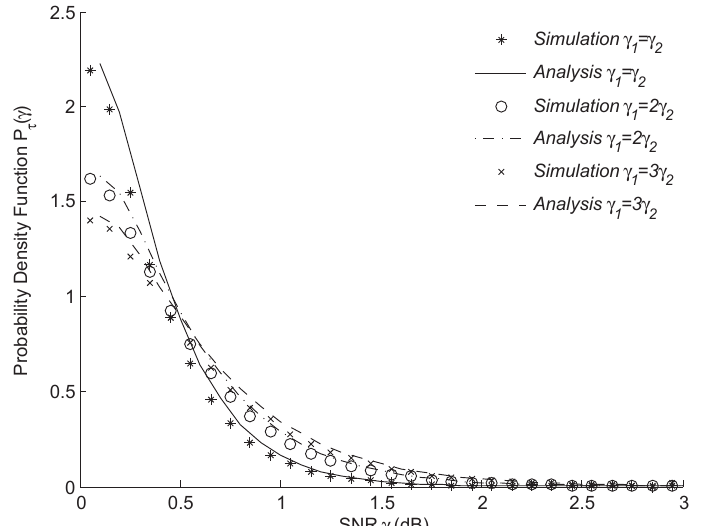
Figure 3. A comparison between the analytical results for the Probability Density Function (PDF) of a full link and the simulation results in different signal-to-noise ratio (SNR) cases.